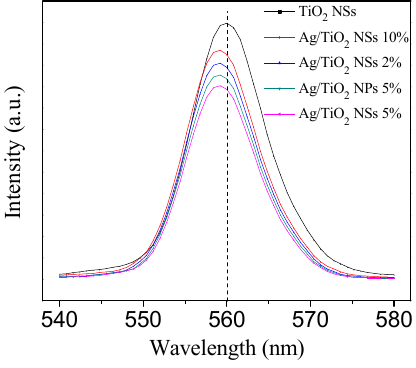
Figure 8. PL spectra of different catalysts.